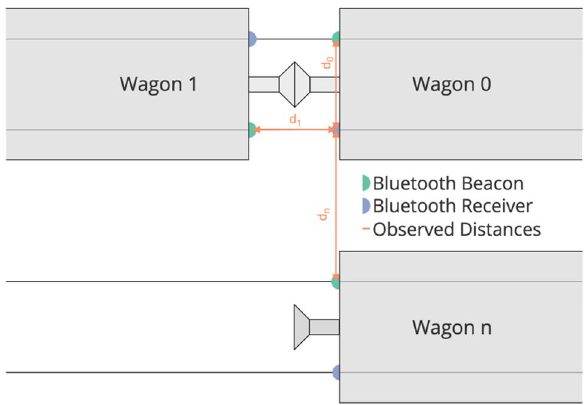
Fig. 6 Connection example: wagons 0 and 1 form a rake, wagon n would lead to a false